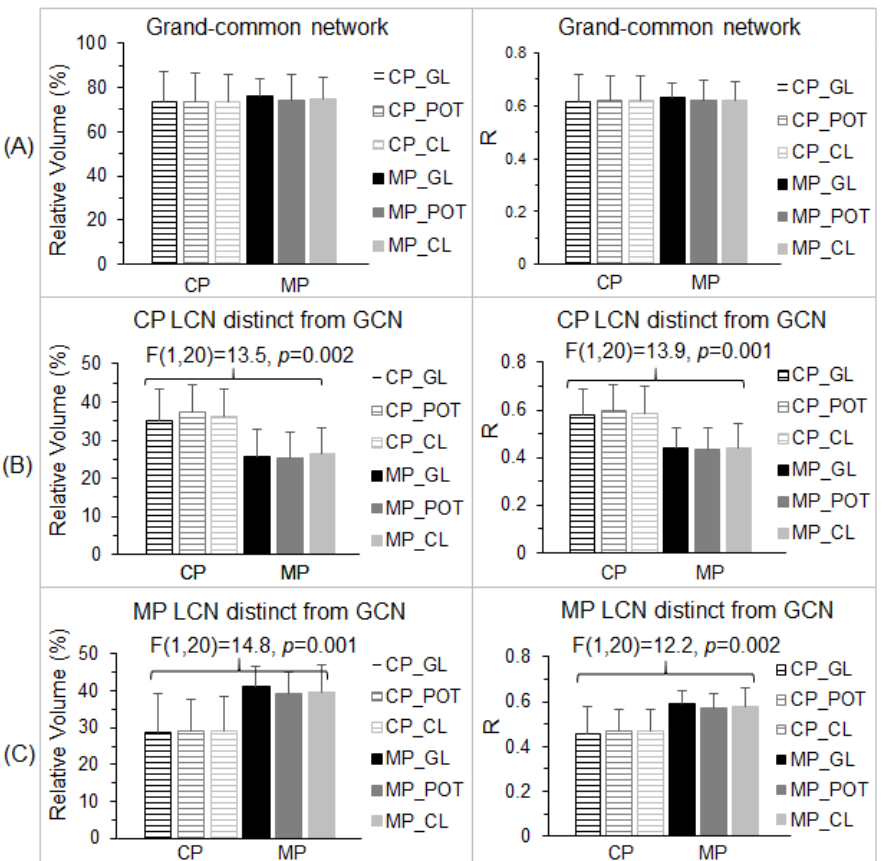
Figure 5. Group comparisons of the two visual cortical functional networks for the gray lens (GL), precision ophthalmic tint (POT), and color lens (CL). ( A ): For the grand-common network (GCN) (Figure 4C, left), the group-mean relative volume (left) and R values (right) were at the same level for all three lens types and two groups of control participants (CP) and migraine patients (MP). ( B ): For the part of the lens-common network (LCN) of the CP distinct from the GCN (Figure 4C, middle), the group-mean relative volume (left) and R values (right) of the CP were at the same level for all three lens types. Although the group-mean relative volume and R values of the MP were at the same level for all three lens types, they were significantly smaller than that of the CP. ( C ): For the part of the LCN of the MP distinct from the GCN (Figure 4C, right), the group-mean relative volume and R values of the MP were at the same level for all three lens types. The group-mean relative volume and R values of the CP were at the same level for all three lens types, but significantly smaller than those of the MP. The error bars indicate the standard